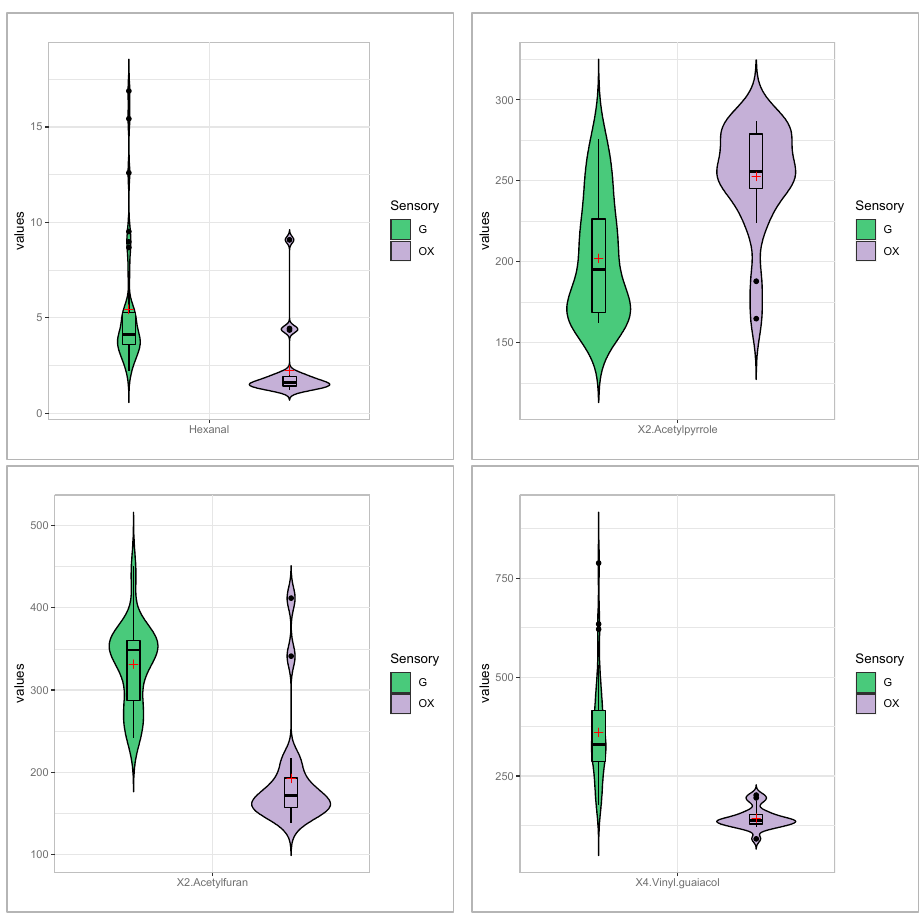
Figure 3. Violin plots of the trends of some markers from the literature in analysed samples. (+) represents the mean.